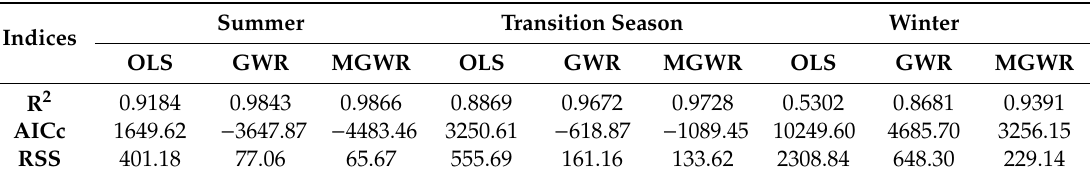
Table 4. An evaluation summary of the performance of ordinary least squares (OLS), geographically weighted regression (GWR) and multi-scale geographically weighted regression (MGWR).